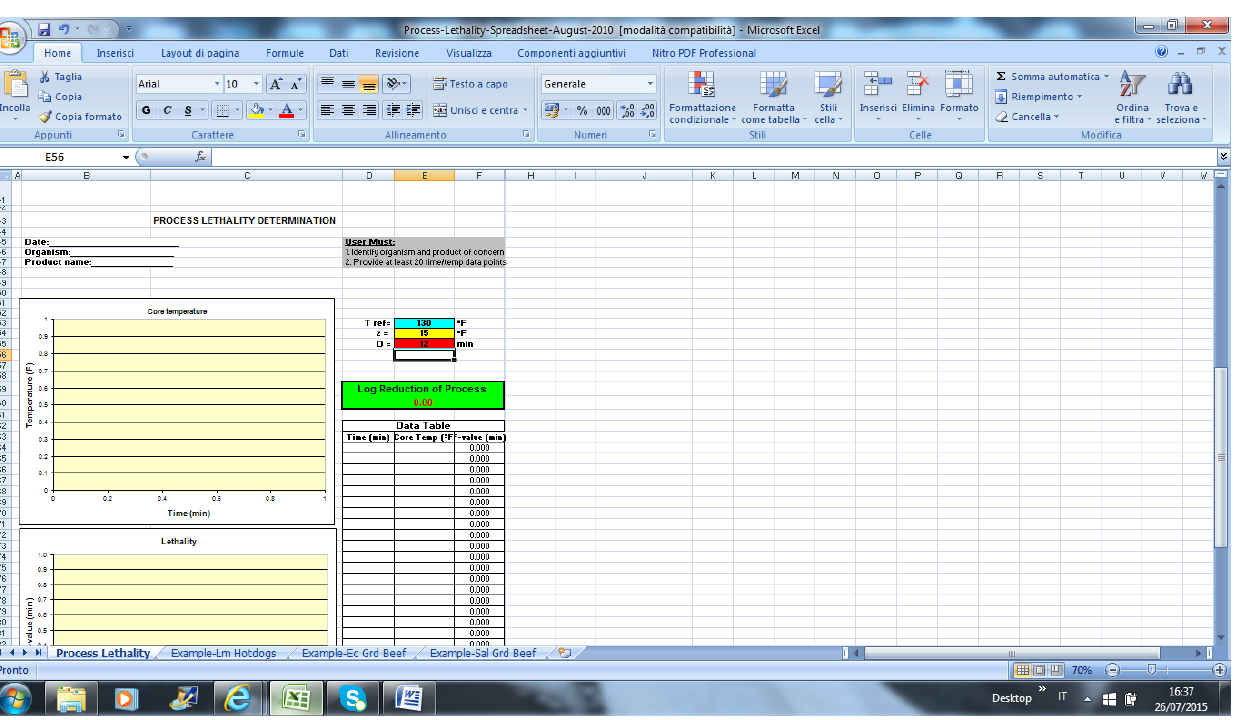
Figure 4. Advanced calculation in MLA.